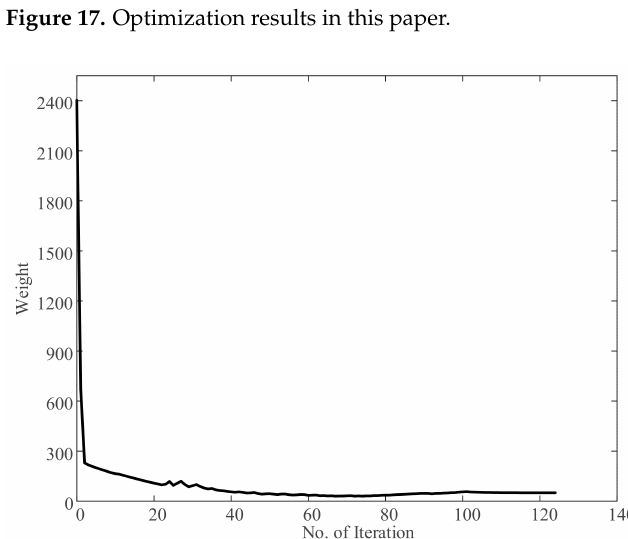
Figure 18. Iteration history for the 662-bar